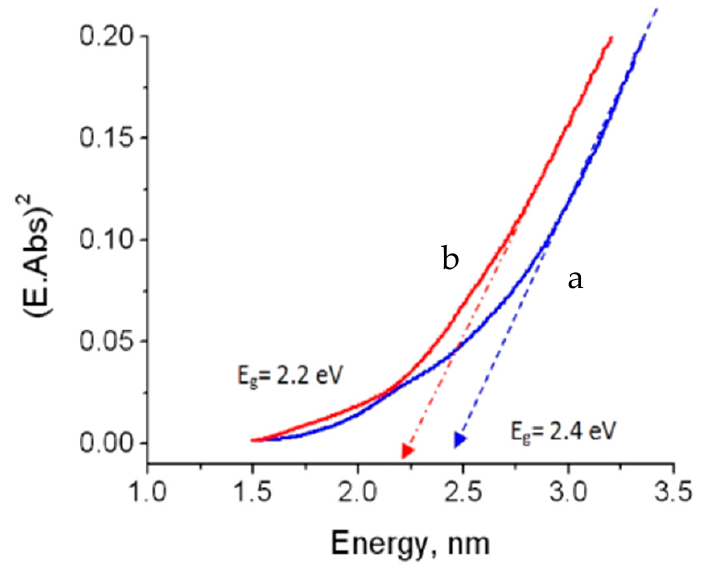
Figure 12. Band gap energy of: ( a ) BT2 and ( b ) BT1.